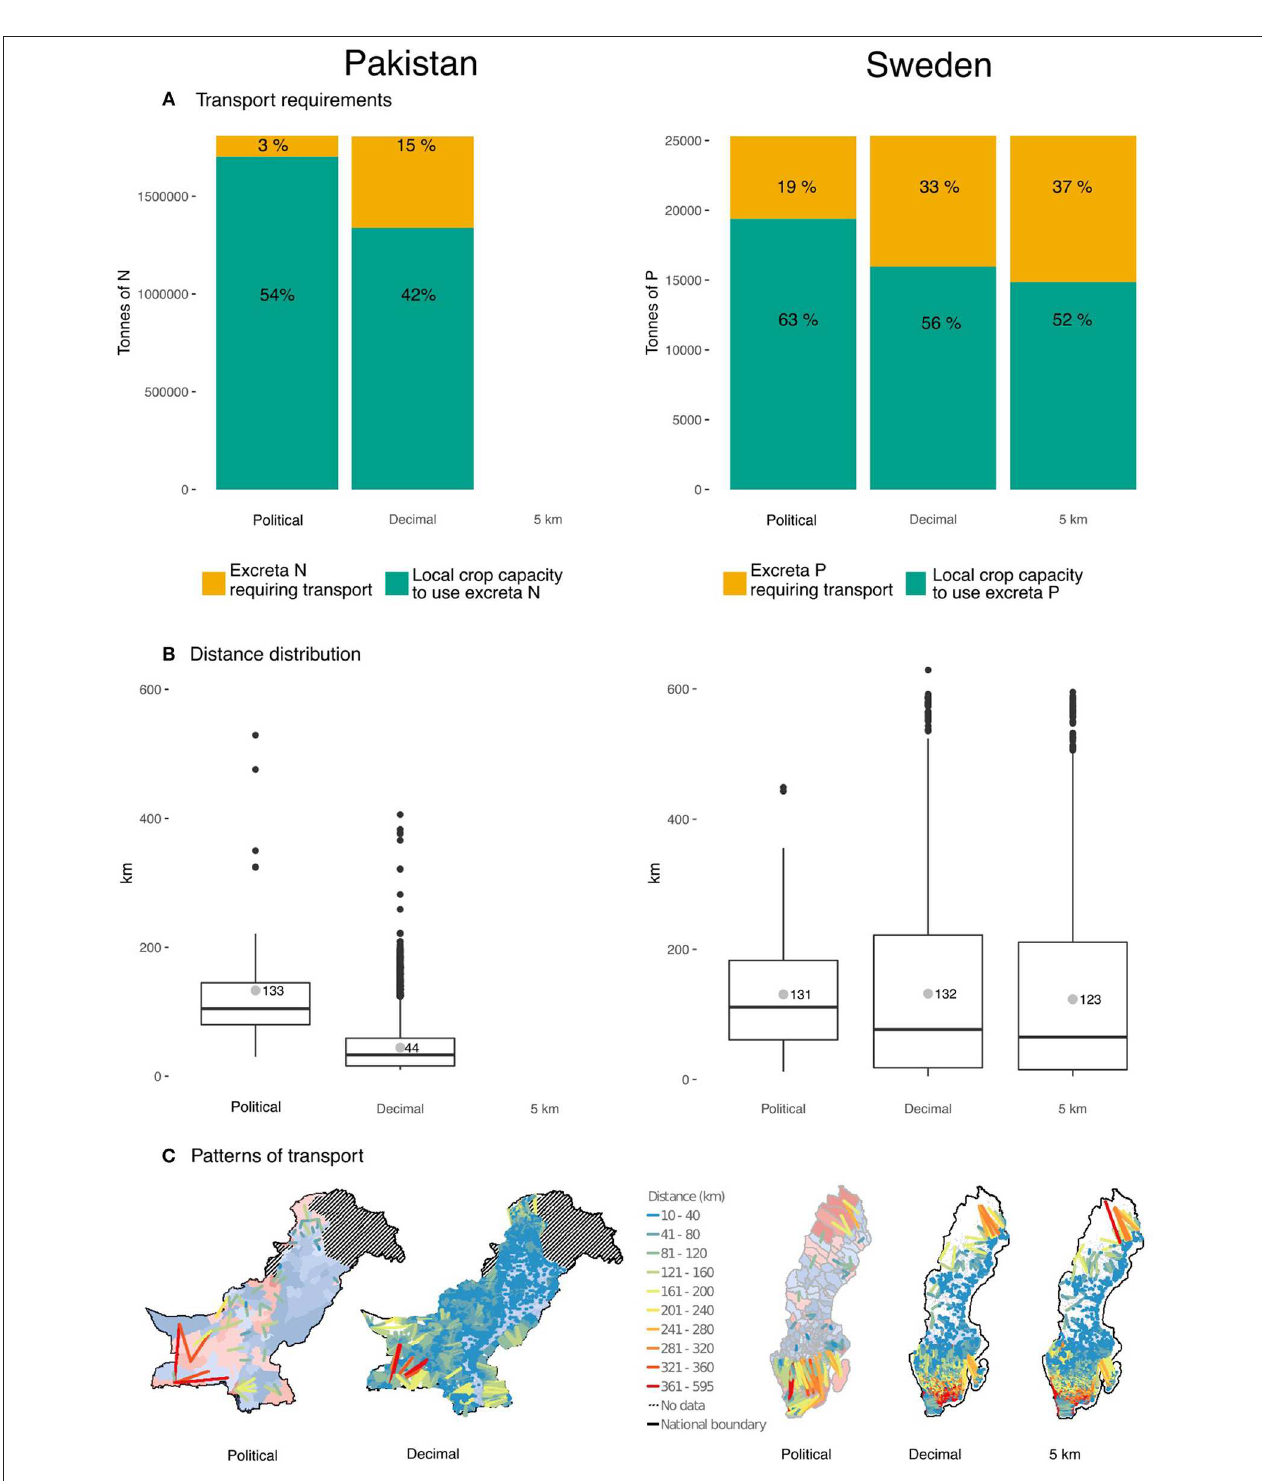
FIGURE 3 | Effects of increasing resolution from political, to decimal, to 5km scales on the transportation of surplus nutrients in terms of (A) the amount and percentage of the nutrient of interest (N for Pakistan and P for Sweden) requiring transport, (B) the spread of transport distances represented as mean (gray circles and stated value), median (center line), interquartile range (box representing 50% of the data), 1.5 times the interquartile range (whiskers), and outliers (black circles), and (C) the paths and distances of transportation on the landscape from surplus (light red) to deficit areas (light blue) color-coded from shorter (blue lines) to longer (red